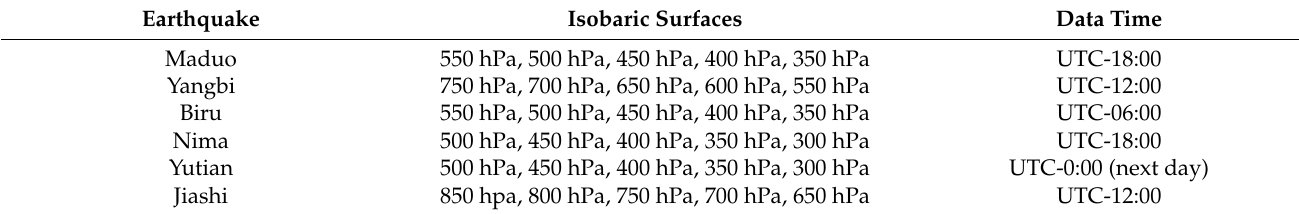
Table 2. The selection of isobaric surfaces and data time for the studied earthquakes. Earthquake Isobaric